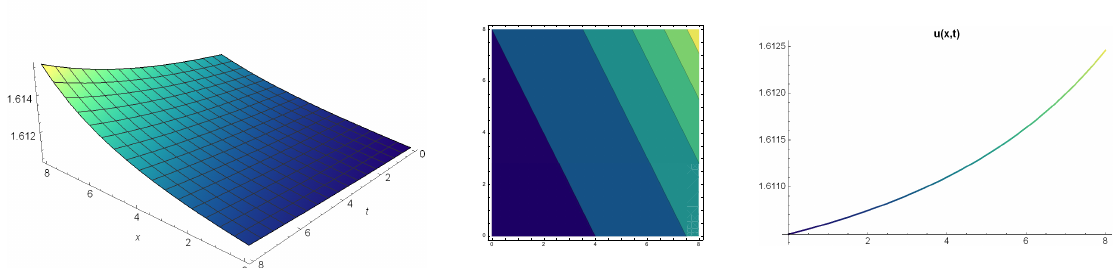
Figure 9. 3D, contour and 2D graphs respectively for c 2 = − 0.1, c 1 = 2, a 2 = 2, p = − 0.5, a 0 = 5 values of Equation